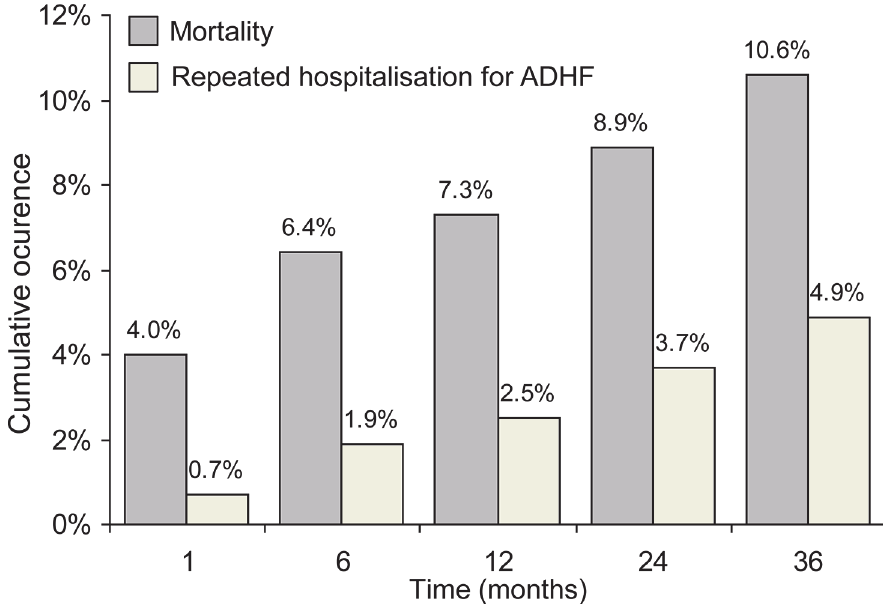
Fig 1. Cumulative occurrence of mortality and repeat hospitalisation for ADHF over